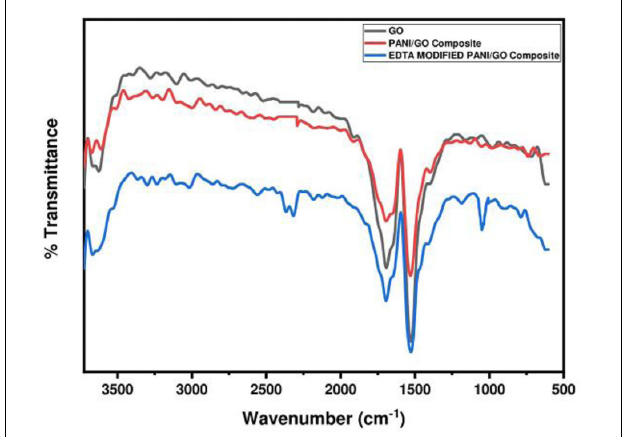
FIGURE 5 | FTIR spectrum of GO, PANI/GO composite, and EDTA modified PANI/GO